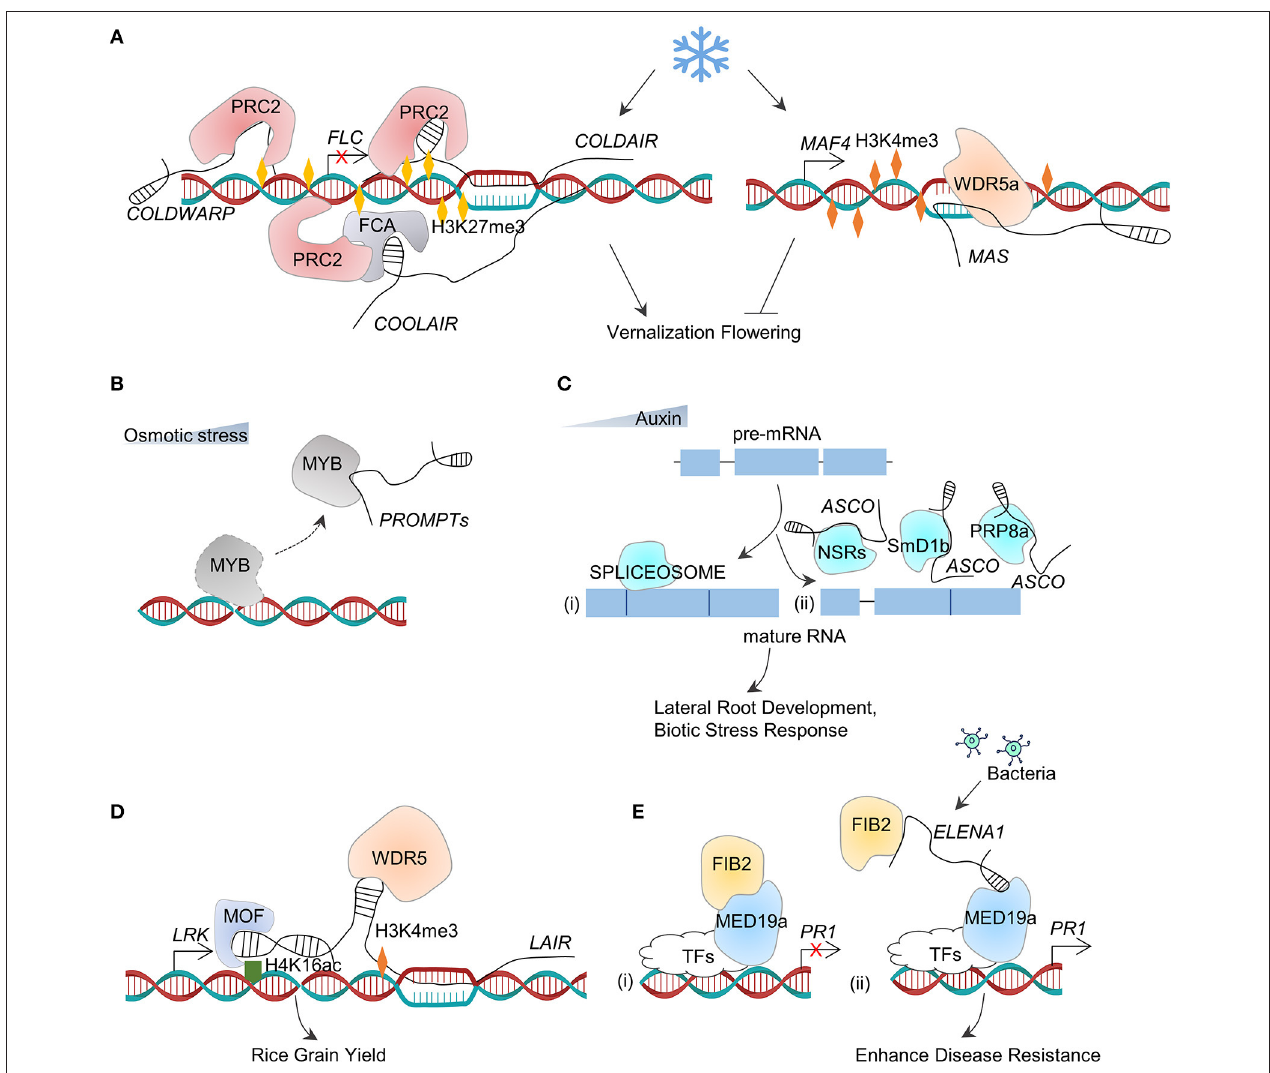
FIGURE 5 | LncRNA–protein interactions. (A) During vernalization, cold temperature induces COLDAIR , COLDWARP , and COOLAIR. Then , COLDAIR and COLDWARP recruit PRC2 to enrich H3K27me3 in the regulation region of FLC to repress its expression, whereas COOLAIR directly binds with FCA to recruit PCR2 and deposit H3K27me3 in the chromatin of FLC . At the same time, cold signal induces the expression of MAS and then recruits WDR5a to deposit H3K4me3 in the chromatin of MAF4 to increase its expression. Downregulation of FLC and upregulation of MAF4 ensure the accurate flowering time during vernalization. (B) Under osmotic stress, PROMPTs act as decoys to hijack the MYB transcription factors (TFs) for preventing their regular functions as TFs in regulating gene transcription. (C) During alternative splicing of pre-mRNA, multiple splicing factors including NSRs, SmD1b, and PRP8a binds (ii) or not (i) to ASCO , together with pre-mRNA to modulate transcriptome diversity dynamically. (D) LAIR , derived from the antisense transcript of LRK , directly interacts with the genomic region of LRK and then acts as a scaffold to recruit MOF and WDR5 to deposit H4K16ac and H3K4me3, respectively. This leads to the upregulation of LRK expression and increase of grain yield. (E) (i) In the absence of pathogen (bacteria) treatment, FIB2 directly interacts with MED19a, and this complex represses PR1 expression; (ii) after the pathogen treatment, the transcription level of lncRNA ELENA1 increases and then binds to FIB2 and MED19a. After FIB2 dissociates, MED19a continues to bind on the promoter of PR1 and activate its